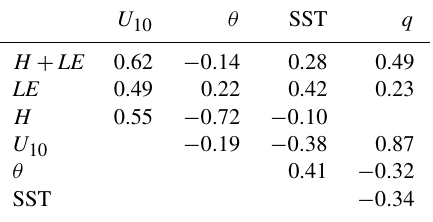
Table 2. Same as Table 1 but at 13:00UTC on 7 November.